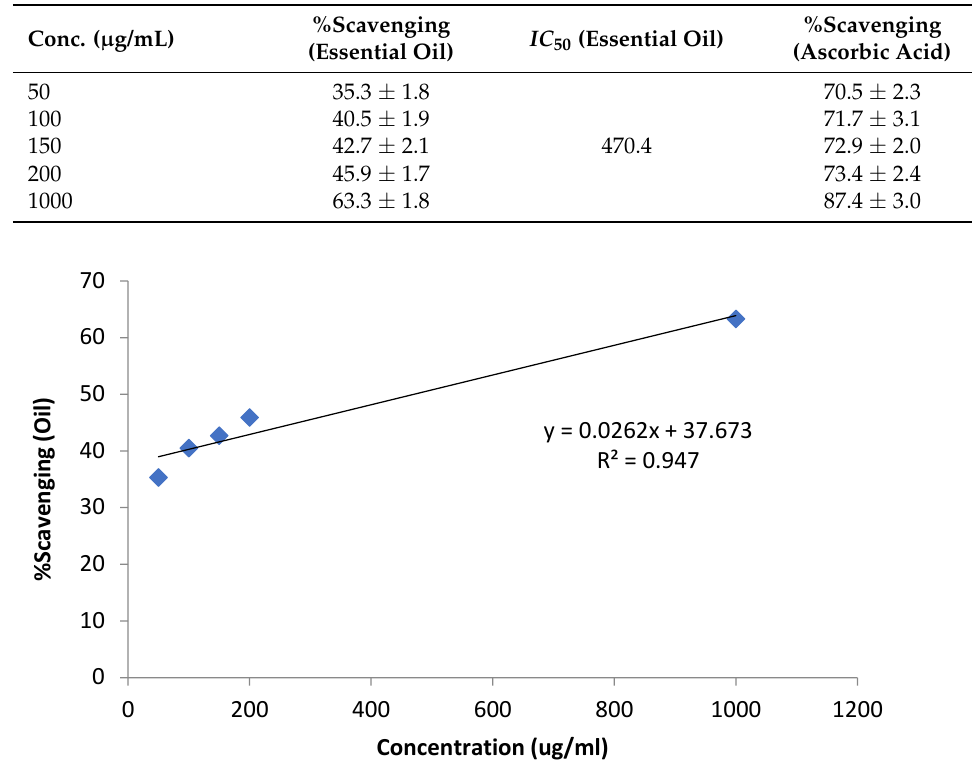
Table 2. Antioxidant activity of U. dioica essential oil.